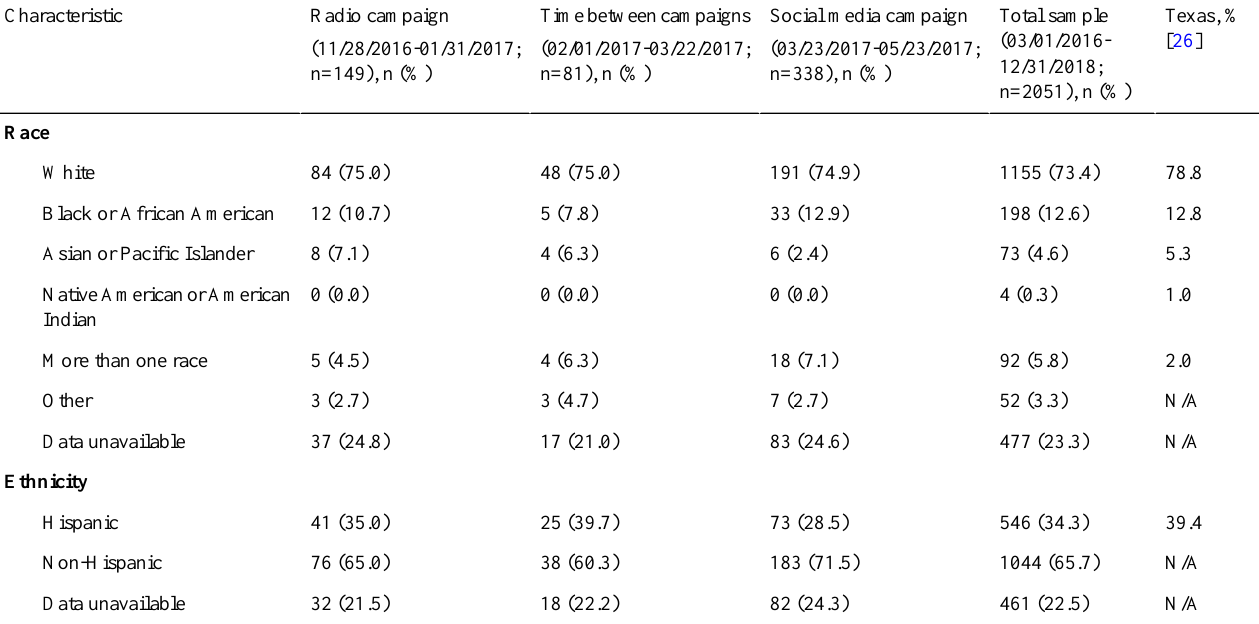
Table 3. Race and ethnicity of participants from media campaigns compared to the population of Texas.